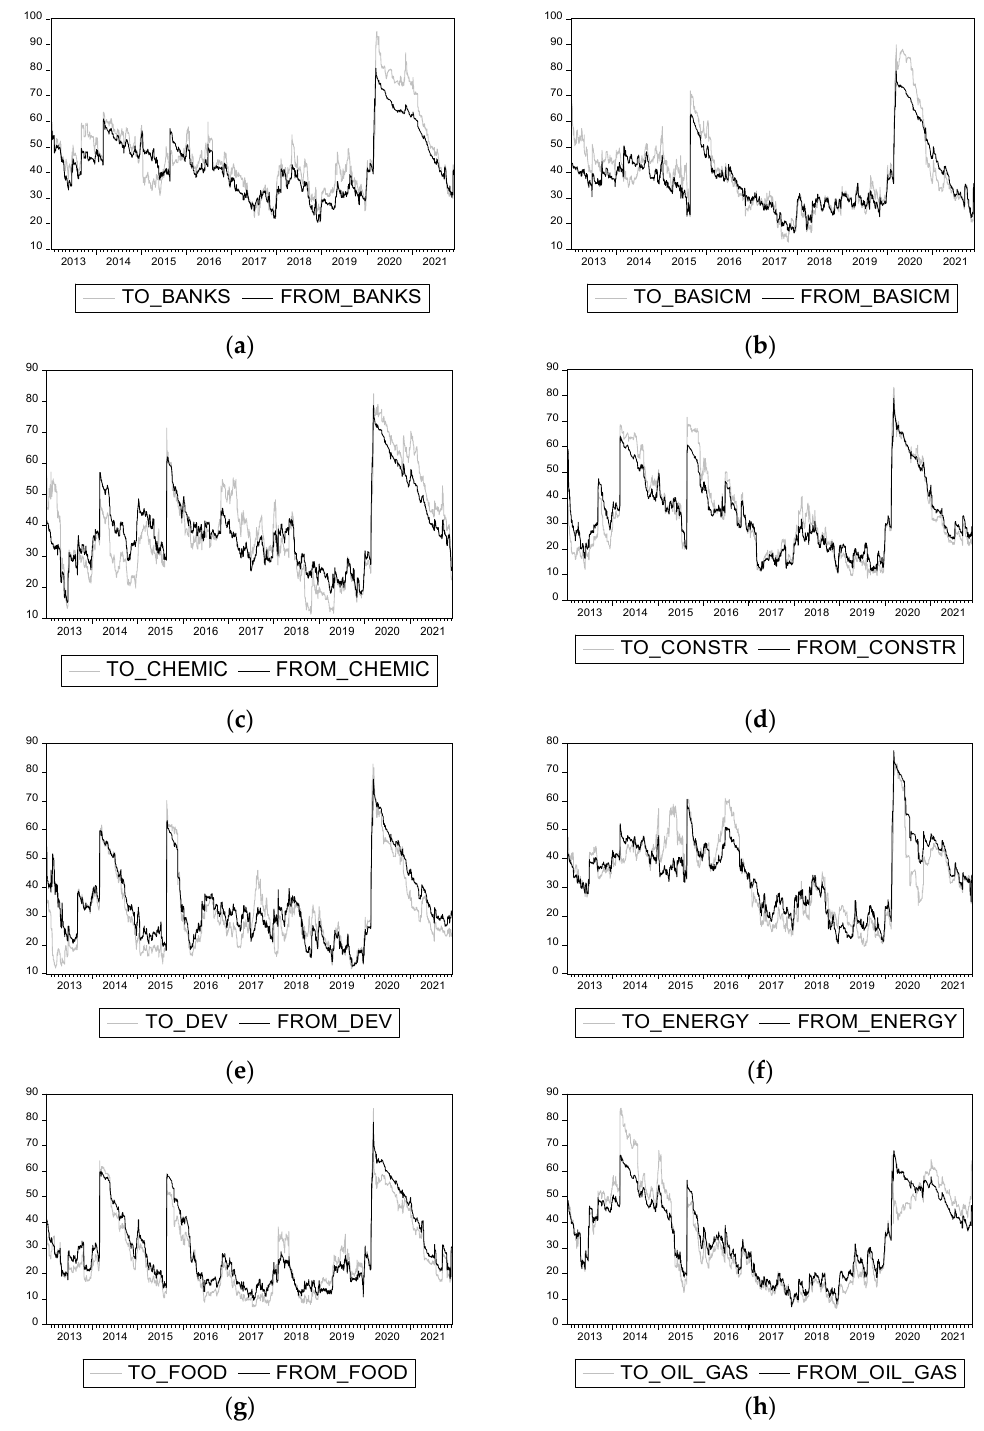
Figure 5. Directional total spillovers from one sector to all sectors (FROM) and from all sectors to a single sector (TO) on the Polish stock market in the period of 1 January 2013–2 December 2021. Note: ( a ) Banks ( b ) Basicm, ( c ) Chemic, ( d ) Constr, ( e ) Dev, ( f ) Energy, ( g ) Food and ( h ) Oil_Gas represent the sectors banks, basic materials, chemicals, construction, developers, energy, food, and oil and gas, respectively. The results were obtained by the